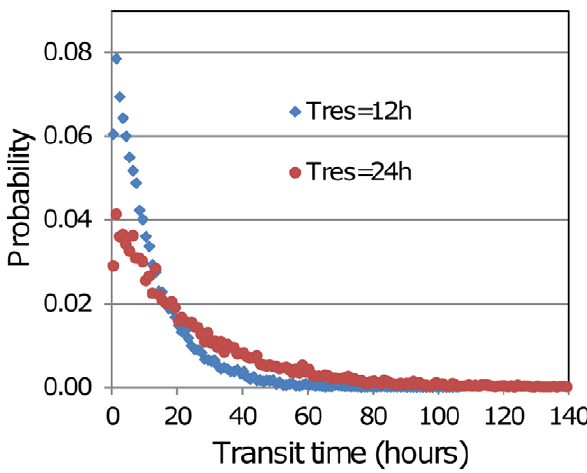
Figure 7. Probability distributions of transit time with no chemotaxis. Two steady-state simulations were carried out of with a T cell population of N =50 k and an influx rate and exit portal count corresponding to a residence times of T res =12 h and 24 h. 10 k cells were tagged on entry and their transit times were recorded on exit. The longest transit time (with T res =24 h) was 205 h, but the graph has been truncated for clarity. (Note that in these simulations no time restriction was placed on the ability of cells to exit immediately after ingress.).